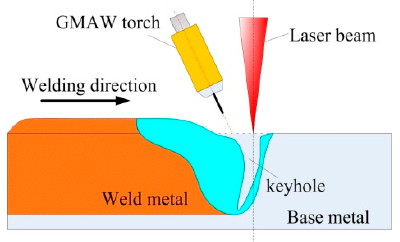
Figure 1. Sketch map of hybrid welding. Table 1. Welding parameters used in the experiments.